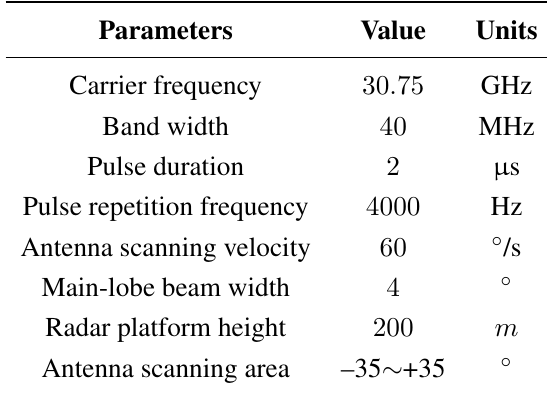
Table 2. Experimental